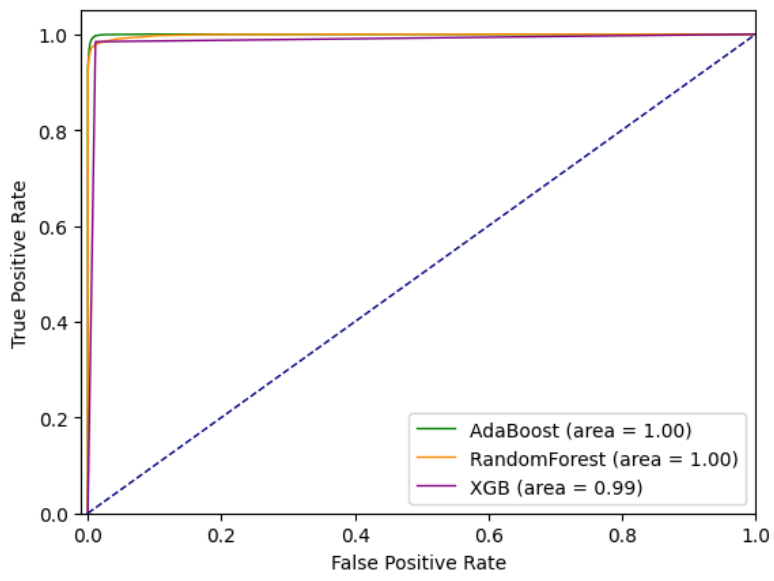
Figure 15. Extended BankSim dataset—comparative ROC curve for ensemble methods.